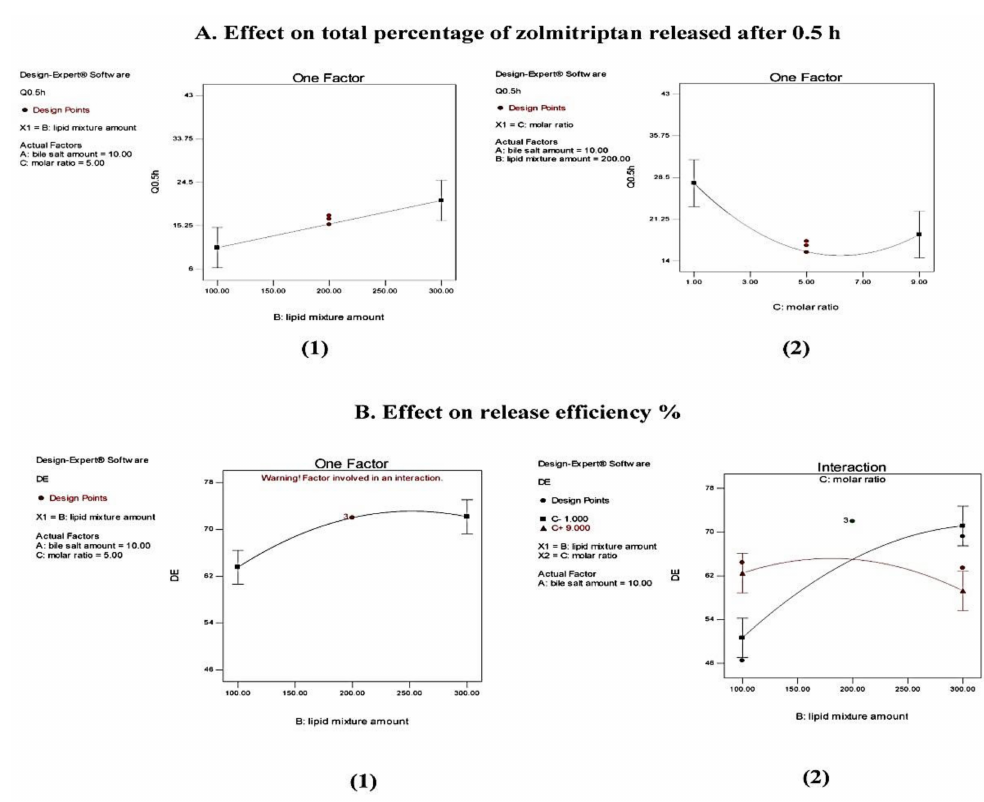
Figure 4. ( A ) Line plots of the effects of cholesterol/Span ® 40 mixture amount (1) and cholesterol: Span ® 40 molar ratio (2) on total percentage of zolmitriptan released after 0.5 h. ( B ) Line plots for the effect of the amount of cholesterol: Span ® 40 mixture (1) and the interaction between it and cholesterol: Span ® 40 molar ratio (2) on release efficiency % of the drug up to 8